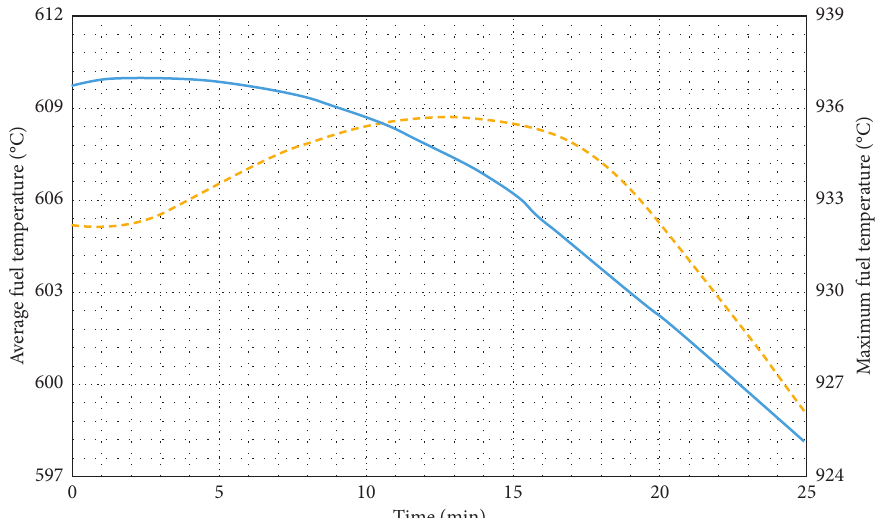
Figure 10: Average and maximum fuel temperature of #2 module in case 1 (solid line: average; dashed line: maximum).